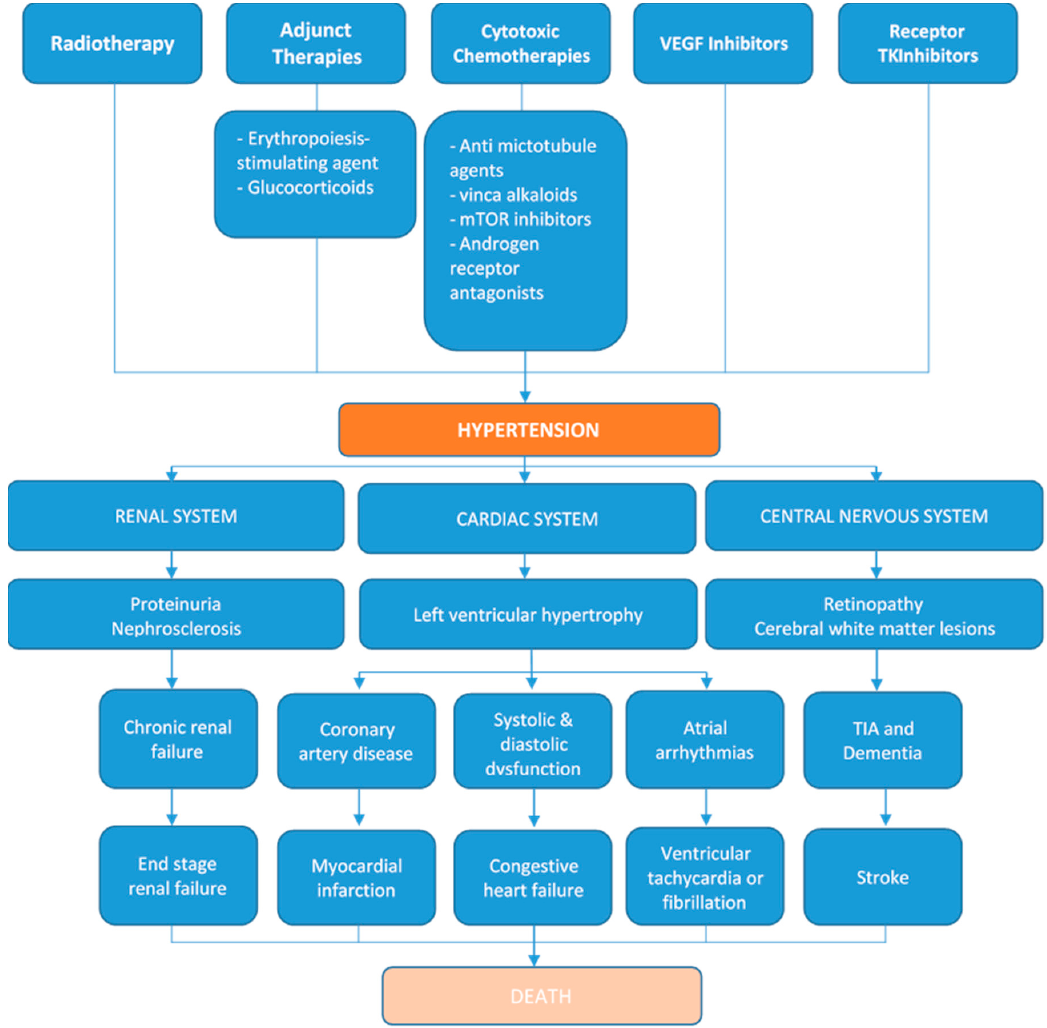
Figure 2. Cancer therapies causing hypertension and their subsequent effects ranging from target- organ damage to final common pathway of end-stage disease [64]. Multiple therapies in cancer